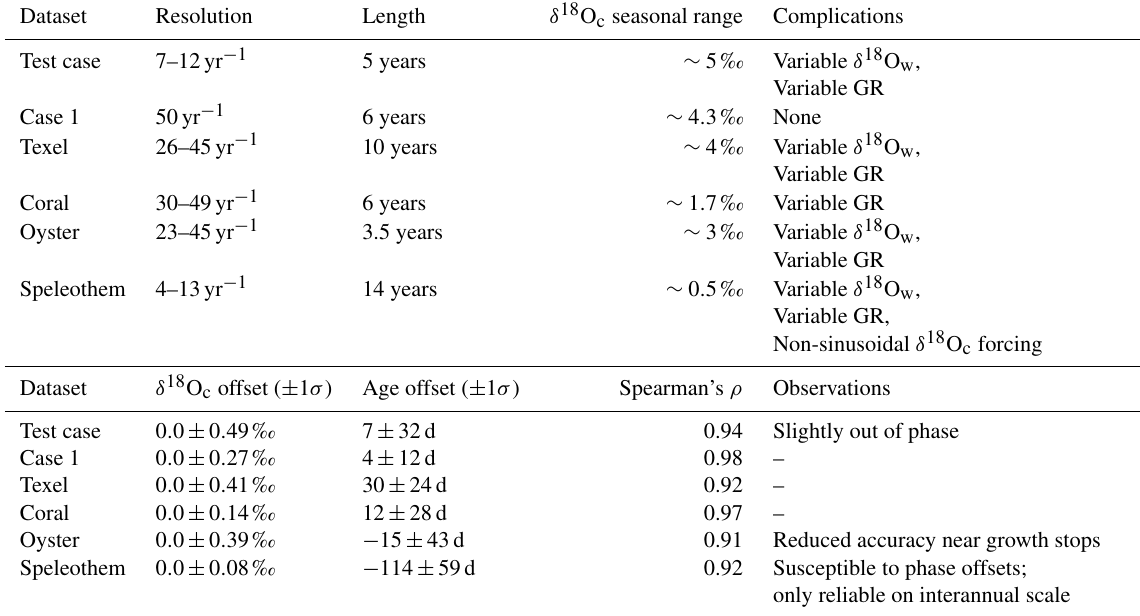
Figure 7. Overview of model results for the three test datasets from real carbonate archives: (a) coral, (b) oyster, and (c) speleothem. Lower panels indicate the fit of individual model windows (in red) with the data (in black), while upper panels show the age model (in red) compared to the “true” age–distance relationship with histograms showing model accuracy (in days, top left) and model fit ( δ 18 O c offset in ‰, bottom right). Color scheme follows Fig. 3. Note that the true age–distance relationship is not known for these natural records but is estimated using known growth seasonality (coral), comparison with in situ temperature and salinity measurements (oyster), or simply by interpolating between annual growth lines (speleothem). See the Supplement for details and SI10 for raw data. Table 2. Overview of datasets and model